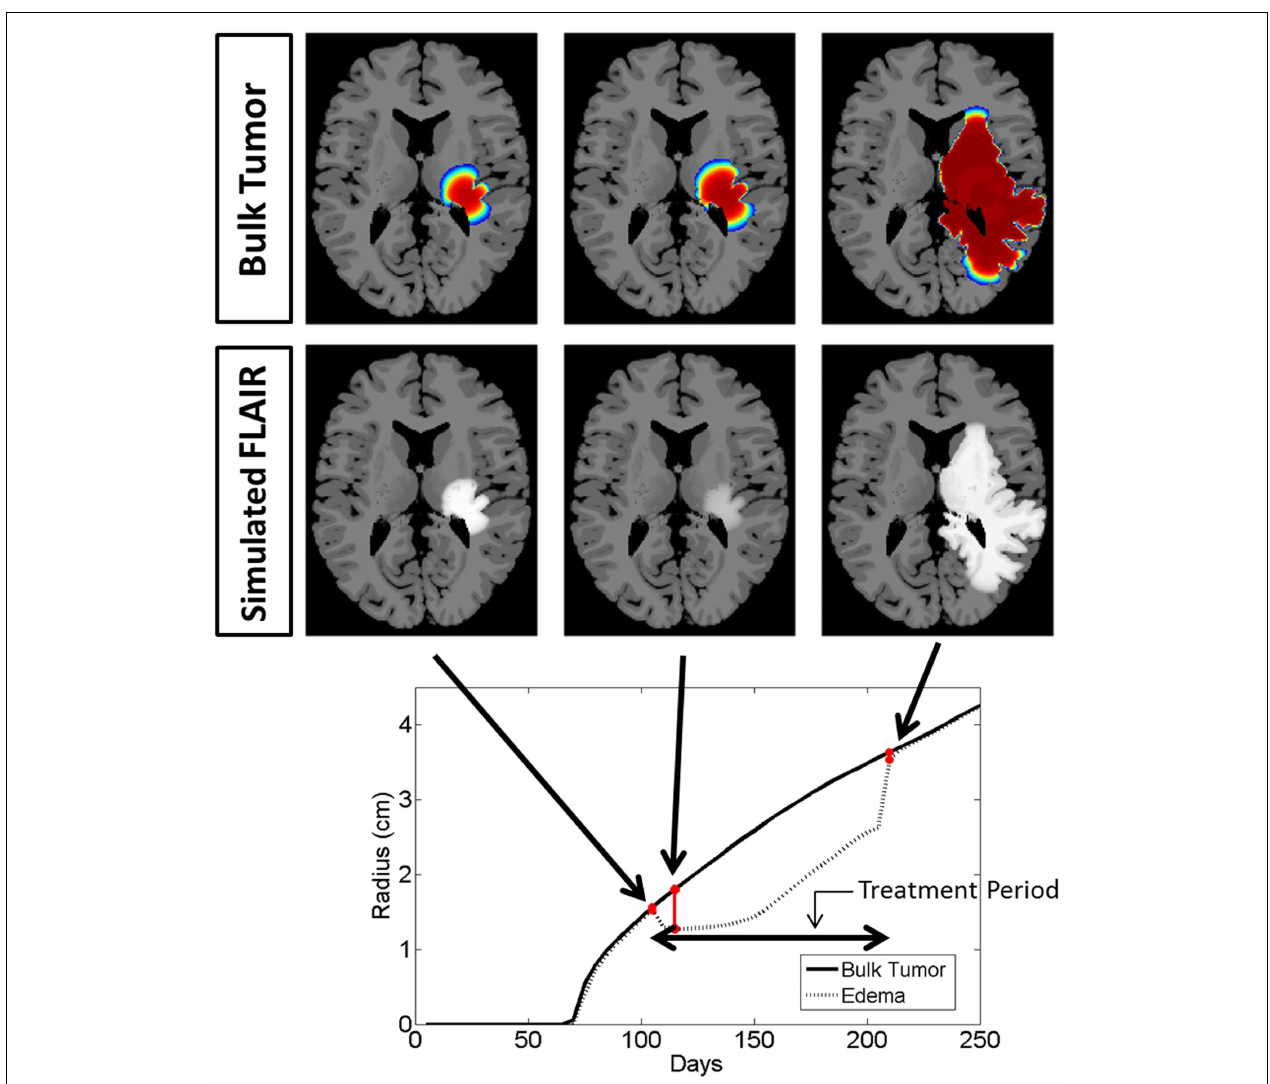
tumor cells above a threshold and edematous fluid above a threshold. Once treatment has begun, we see a drop in the levels of edema. Upon termination of the treatment, the edematous volume is seen to once again increase to the same size of the volume of tumorous